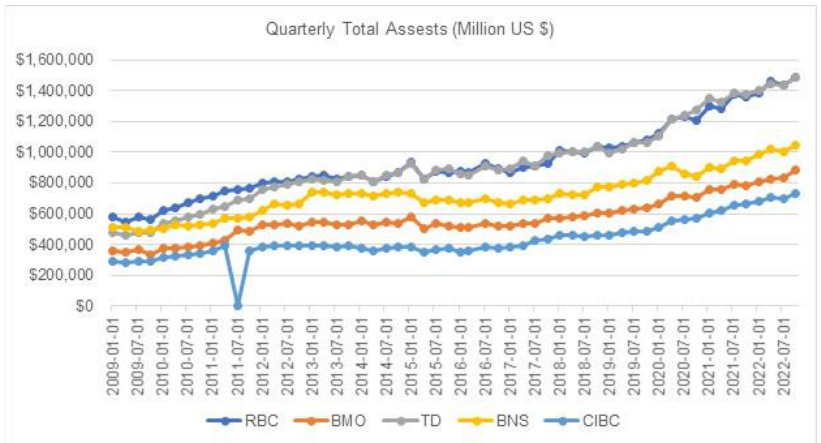
Figure A1. Quarterly total liabilities of the five banks (Source: Data 2 n.d. https://www.macro- trends.net/stocks/charts, accessed on 12 December 2022).